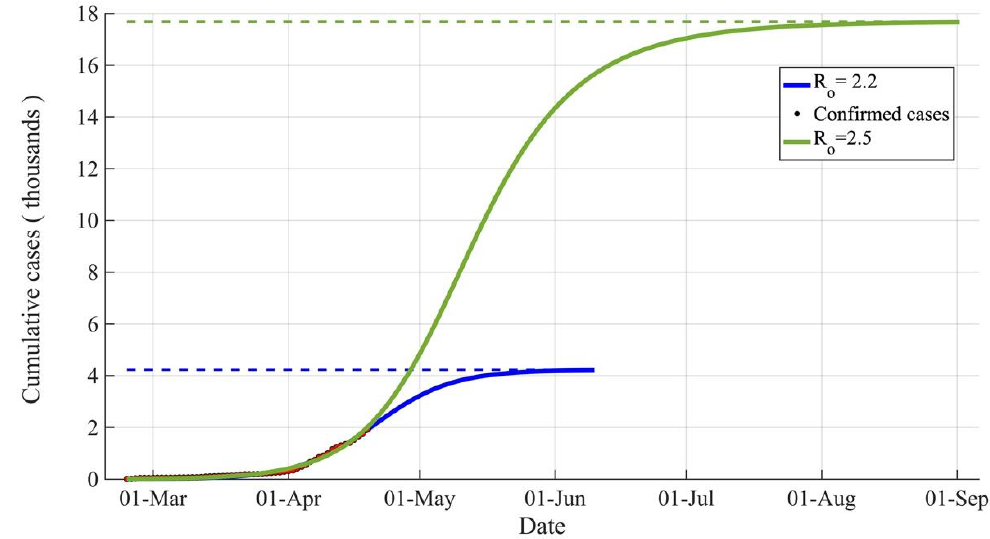
Figure 3. A comparison between the prediction curves of the current estimated reproduction number ( R o = 2.2) and a higher reproduction number of R o = 2.5.